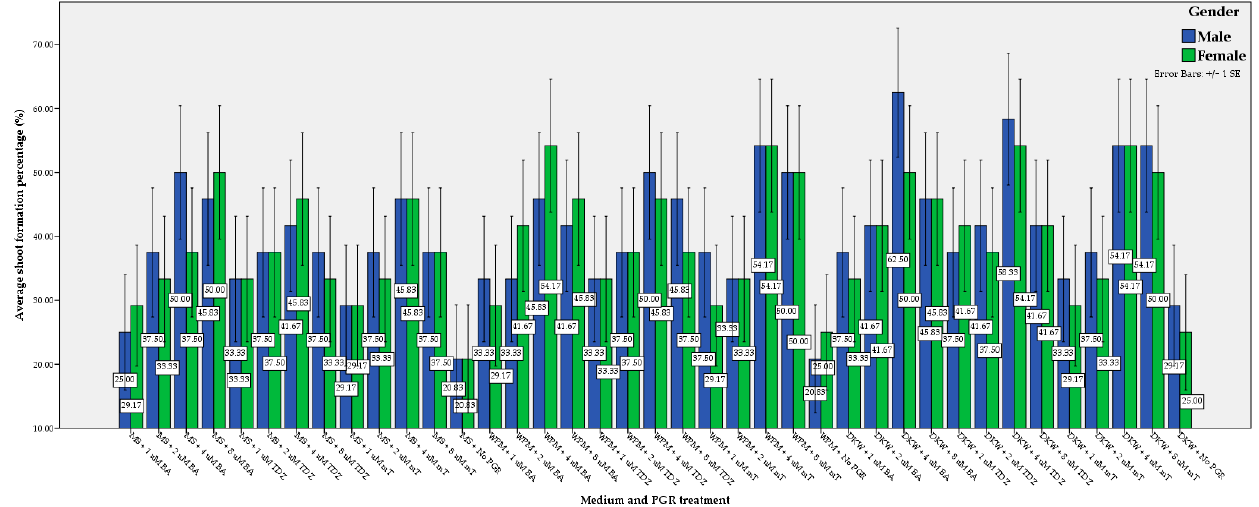
Figure 1. Effect of the medium and plant growth regulator types and their concentrations on the average percentage of blastogenesis (%) of Juniperus drupacea explants in relation to their gender.